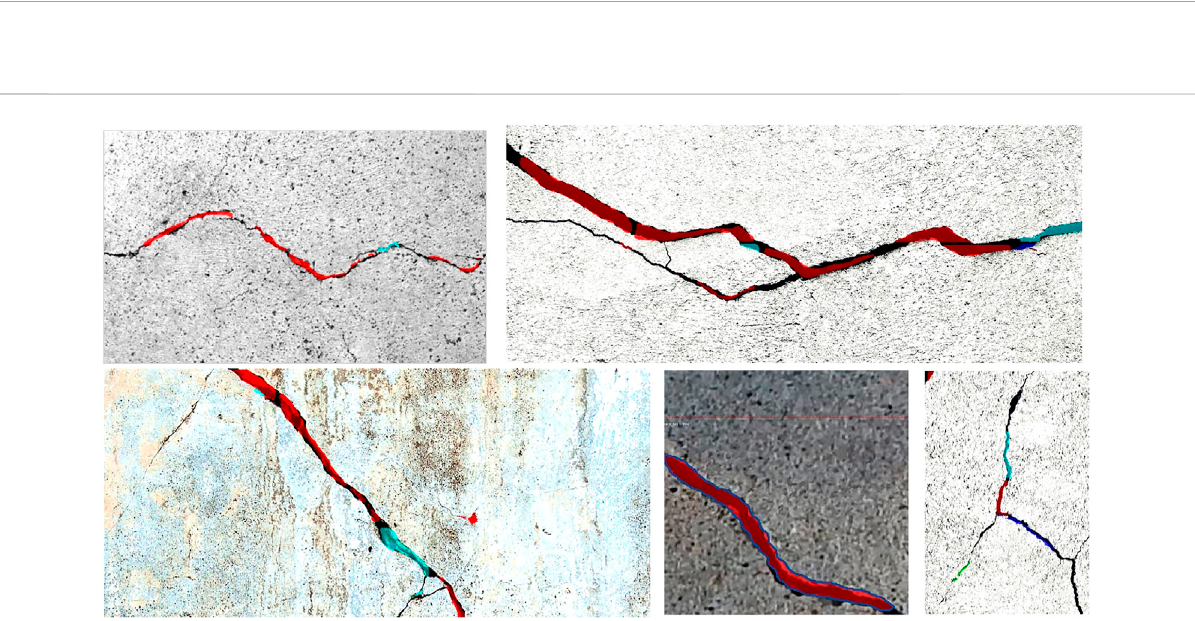
FIGURE 5 Results of the segmentation model applied on different images of